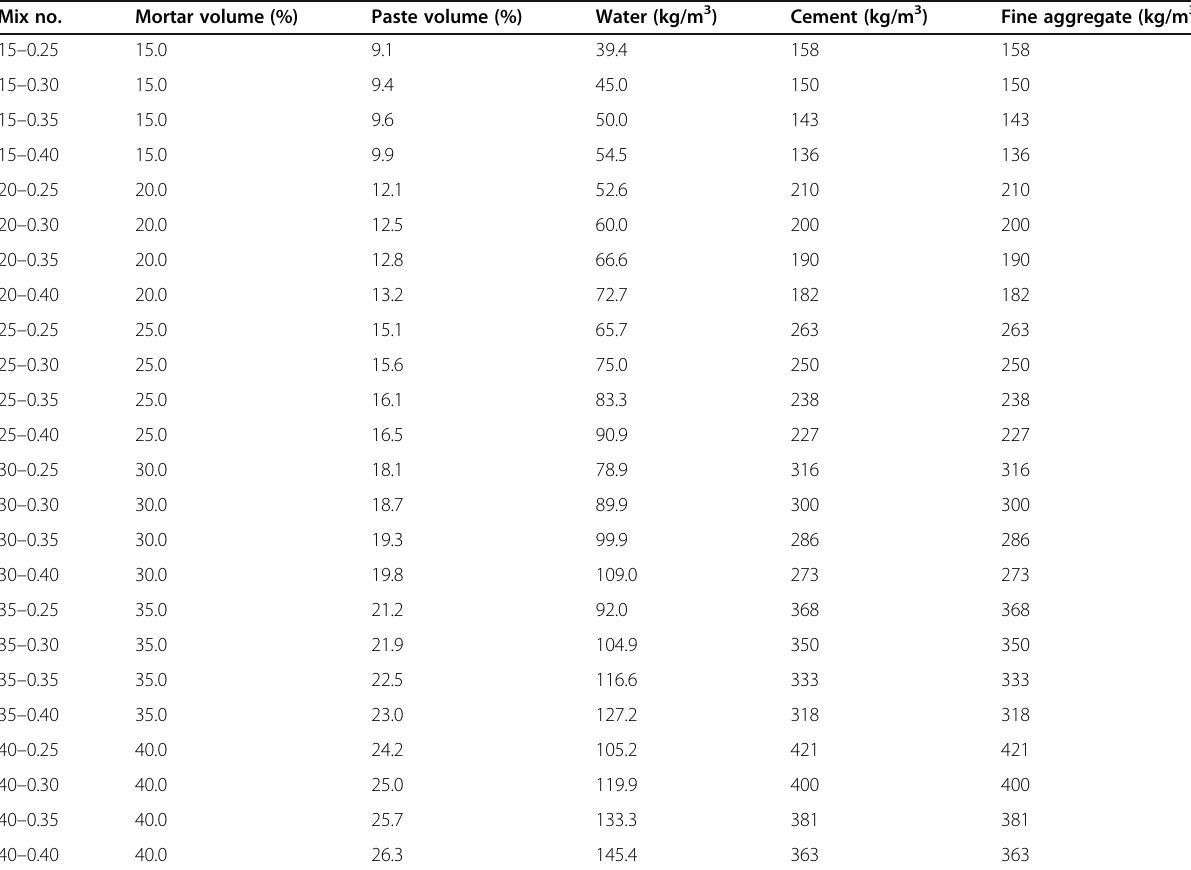
Table 1 Mix proportions of concrete mixes tested Mix